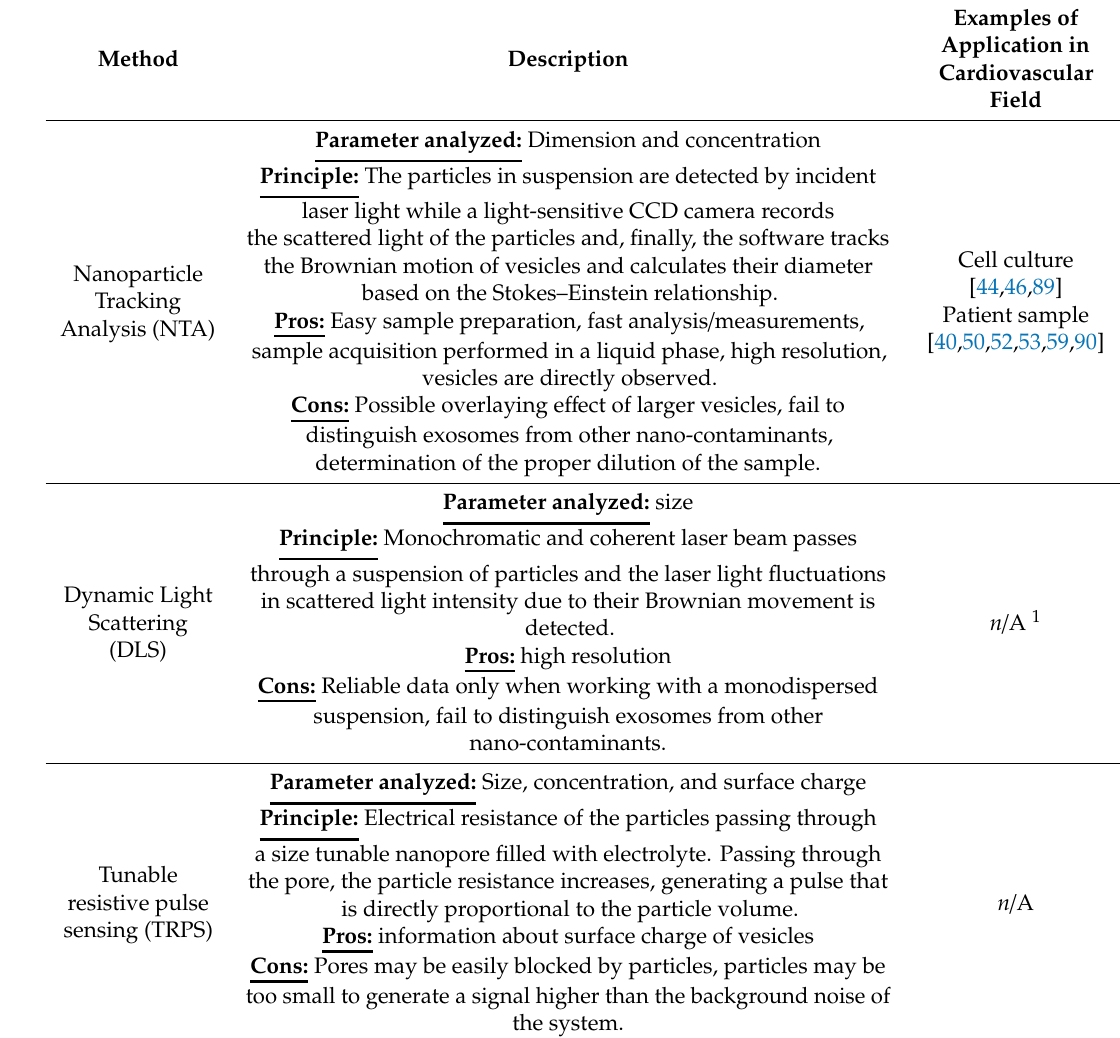
Table 2. Commonly used characterization